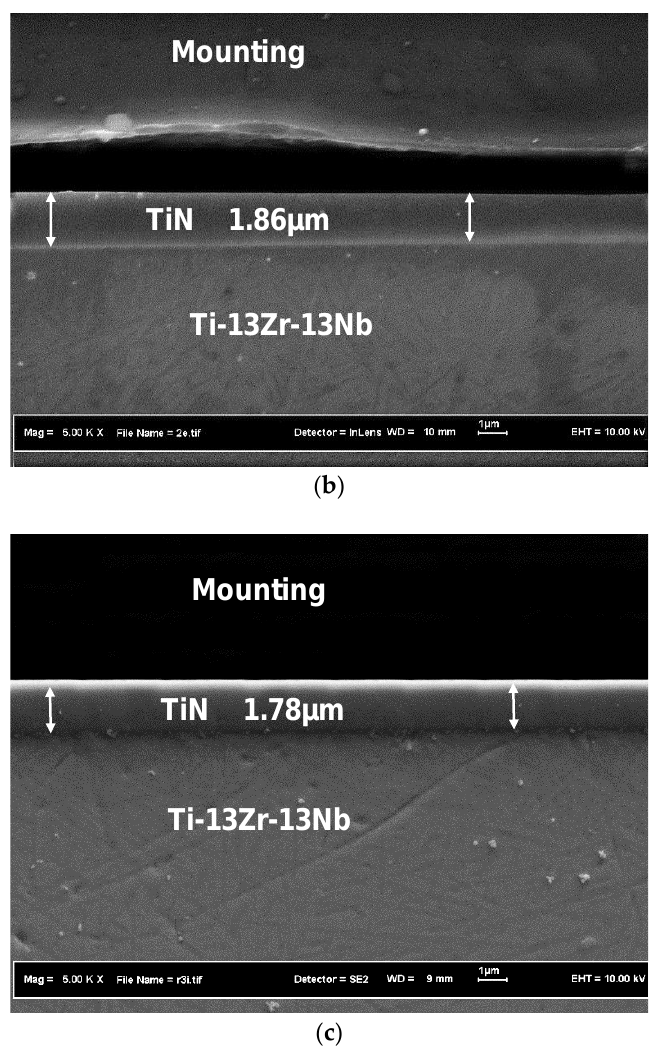
Figure 3. Cross-sectional view of TiN after ultrasonic treatment at 16 kHz for ( a ) 5 min, ( b ) 8 min, and ( c ) 11 min.